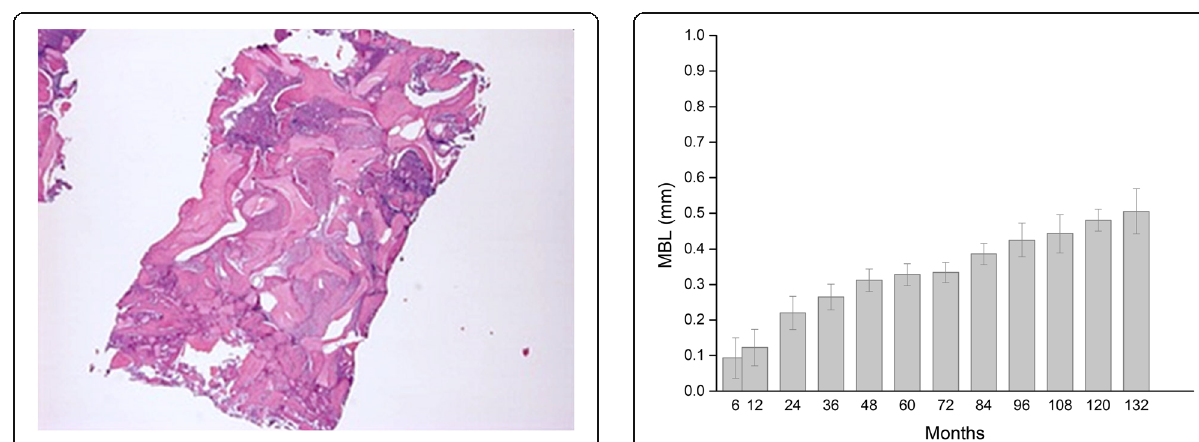
Fig. 6 MBL (marginal bone loss, mm) over time, following final prosthesis delivery, of implants placed within sinuses augmented using the EDEB/PRGF